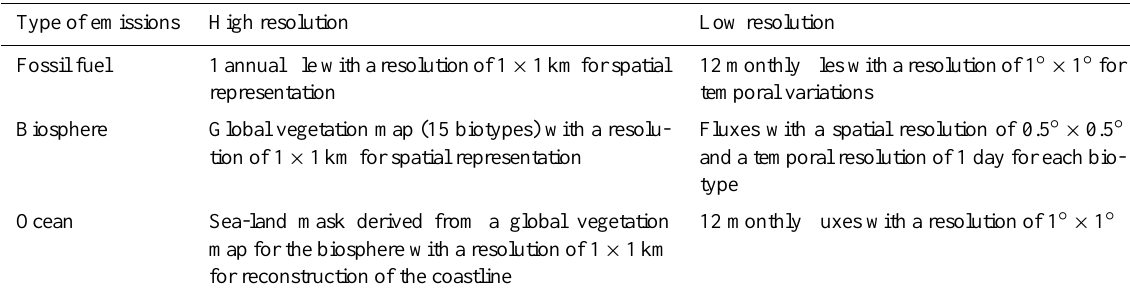
Table 1. Combinations of emissions analysed in this